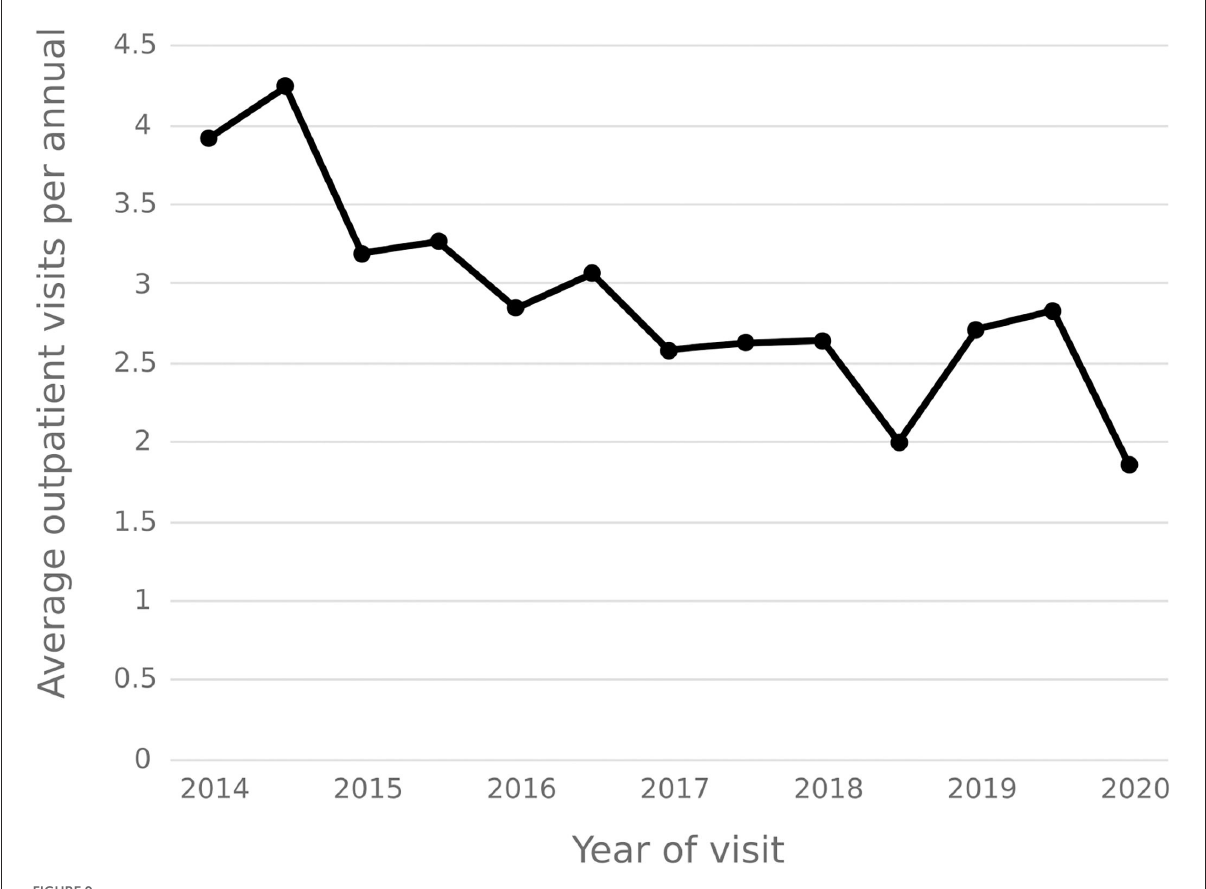
FIGURE9 Average outpatient visits of hepatitis C patient per